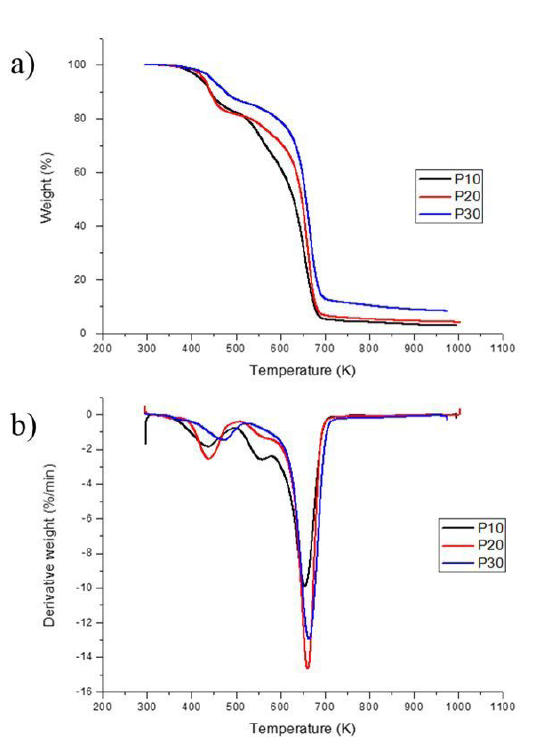
Figure 4. Thermal analyses of P10, P20 and P30: (a) TGA, and (b)